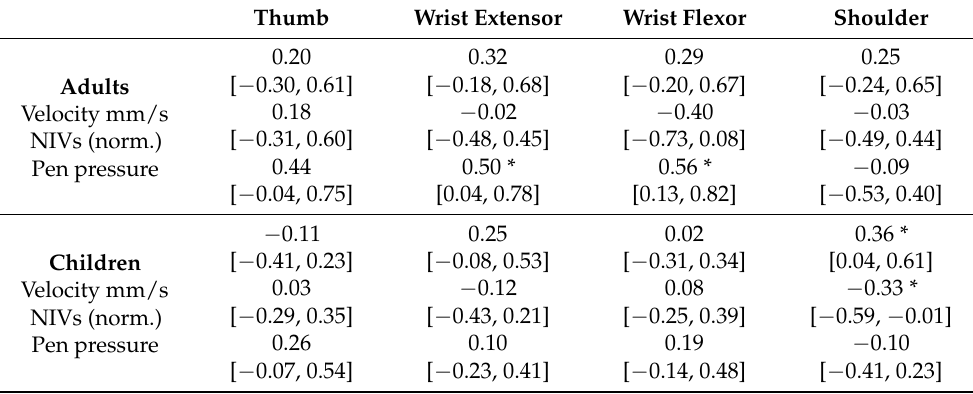
Table 2. Correlations between the muscle activity (normalized sEMG, %MVC) and handwriting process data (tablet data) for each group (adults n = 18 and children n = 37), with confidence intervals in square brackets.